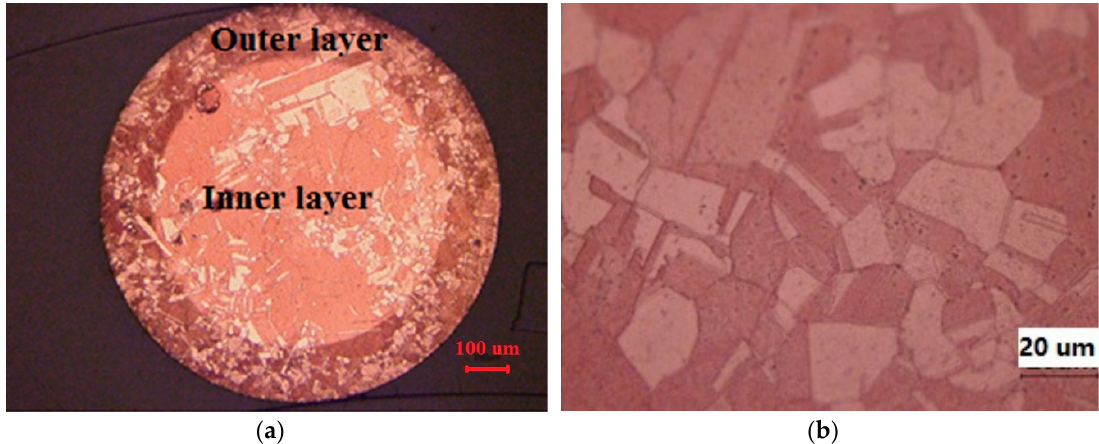
Figure 8. Microstructure of copper wire before micro-rolling (initial diameter: 1 mm). ( a ) Whole initial wire; ( b ) inner layer.